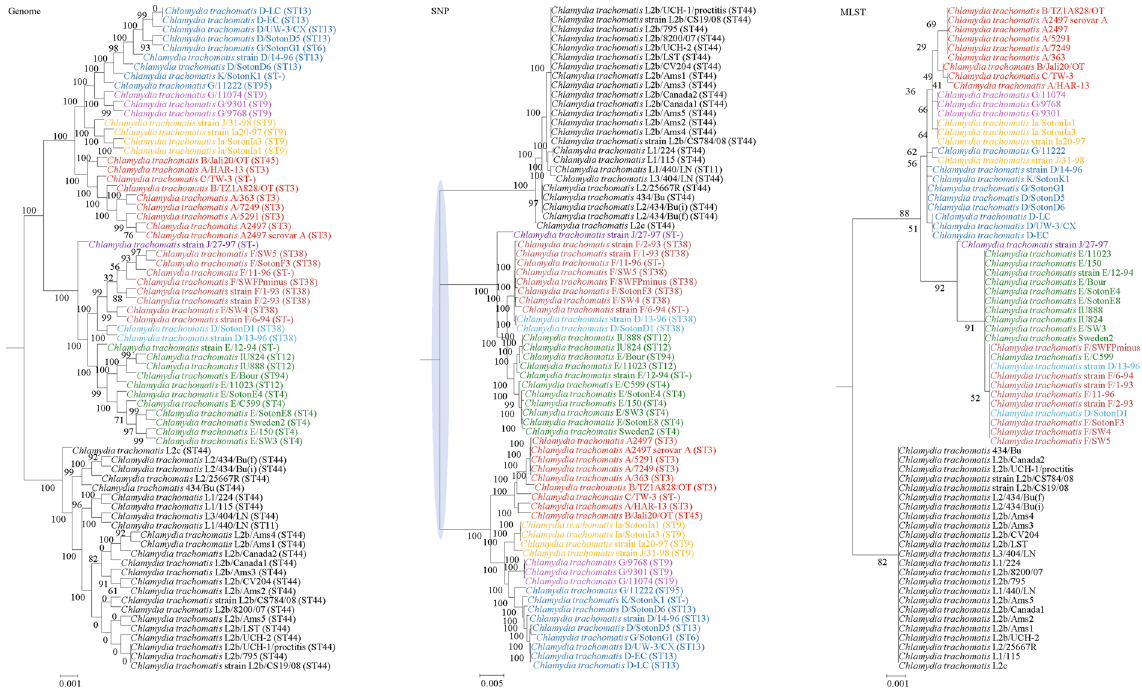
Figure 4. Comparison of phylogenetic trees constructed using genome data (left), SNP data (middle), and MLST data (right) for Chlamydia trachomatis . Clusters that were manually selected based on the genome trees are illustrated in different colors. The unresolved polytomies are shaded in blue. A new sequence type is represented by a dash